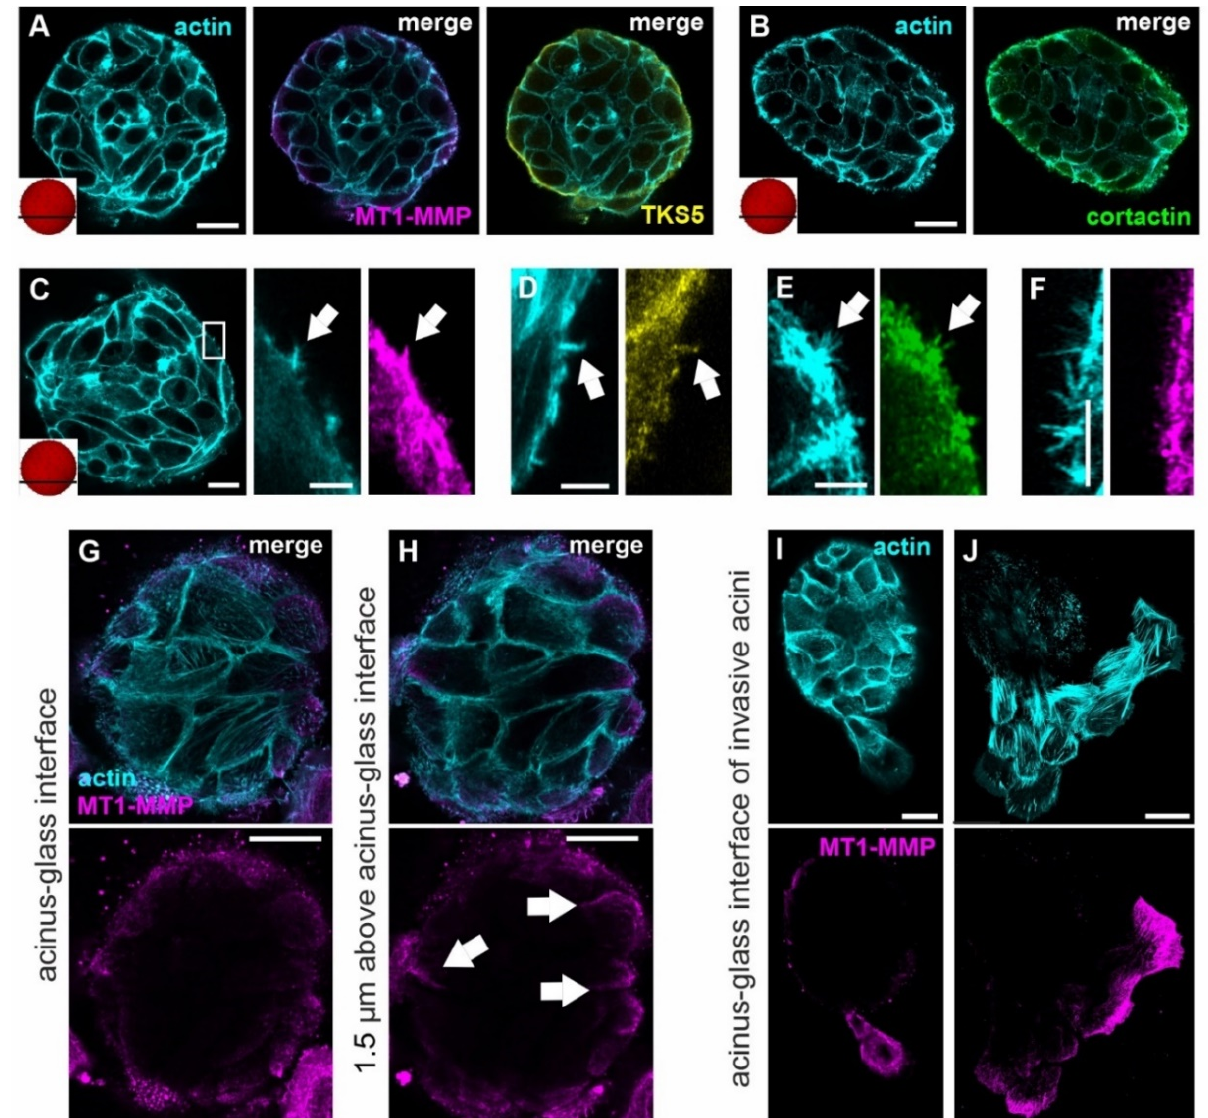
Figure 3. Subcellular localization of invadopodia markers in acinar and invasive cells. MCF10A acini were fixed and IF-stained. ( A – F ): Confocal images of pre-invasive breast acini with intact BM treated with pro-invasive cues (ld-BM, 24 h EGF treatment, glass). ( A , B ): The actin cortex (cyan) of the basal cell layer of pre-invasive acini co-localizes with the invadopodia marker proteins MT1-MMP (magenta), Tks5 (yellow), and cortactin (green) (for single MT1-MMP, TKS5, and cortactin signal see Supplementary Figure S2A. ( C – E ): Visualization of the actin cytoskeleton with small single actin-based lateral MS, co-localized with MT1-MMP ( C ), Tks5 ( D ) and cortactin ( E ). ( F ) Area of high MS density without co-localization of MT1-MMP and actin MS. ( G , H ) MT1-MMP protein localization at cortical actin structures in cells at the BM–substrate interface (cf. A ) (white arrows). ( I , J ): Micrographs showing MT1-MMP at the migration front of invasive cells after BM breakdown. Antibody control staining is provided in Supplementary Figure S2D. Scale bars: ( A – C , G – J ) = 20 µ m, magnifications in ( C – F ) = 5 µ